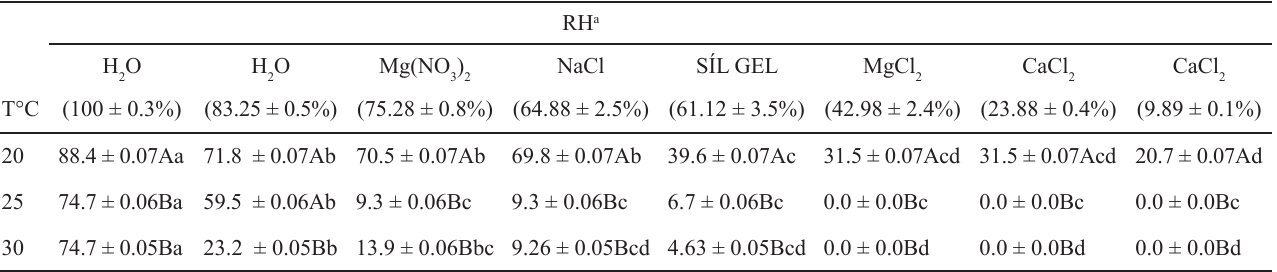
Table 2 . Percentage of survival (M ± SE) of Coptotermes testaceus 24 hours after being exposed to eight RHs and three temperatures. n = 5.